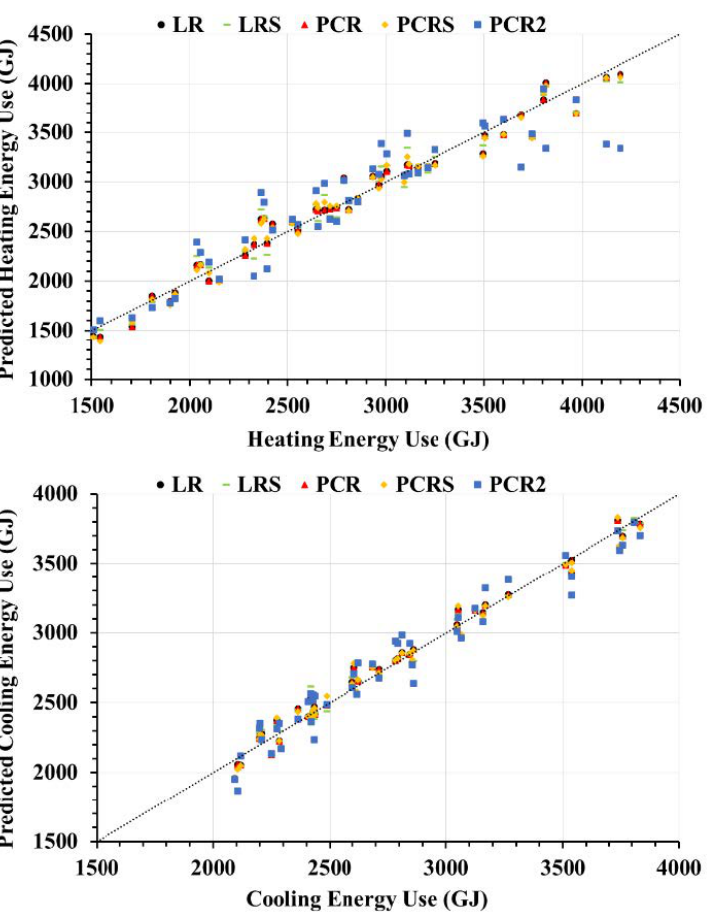
Figure 4. Results of the regression models of prediction for heating and cooling energy use over the simulated